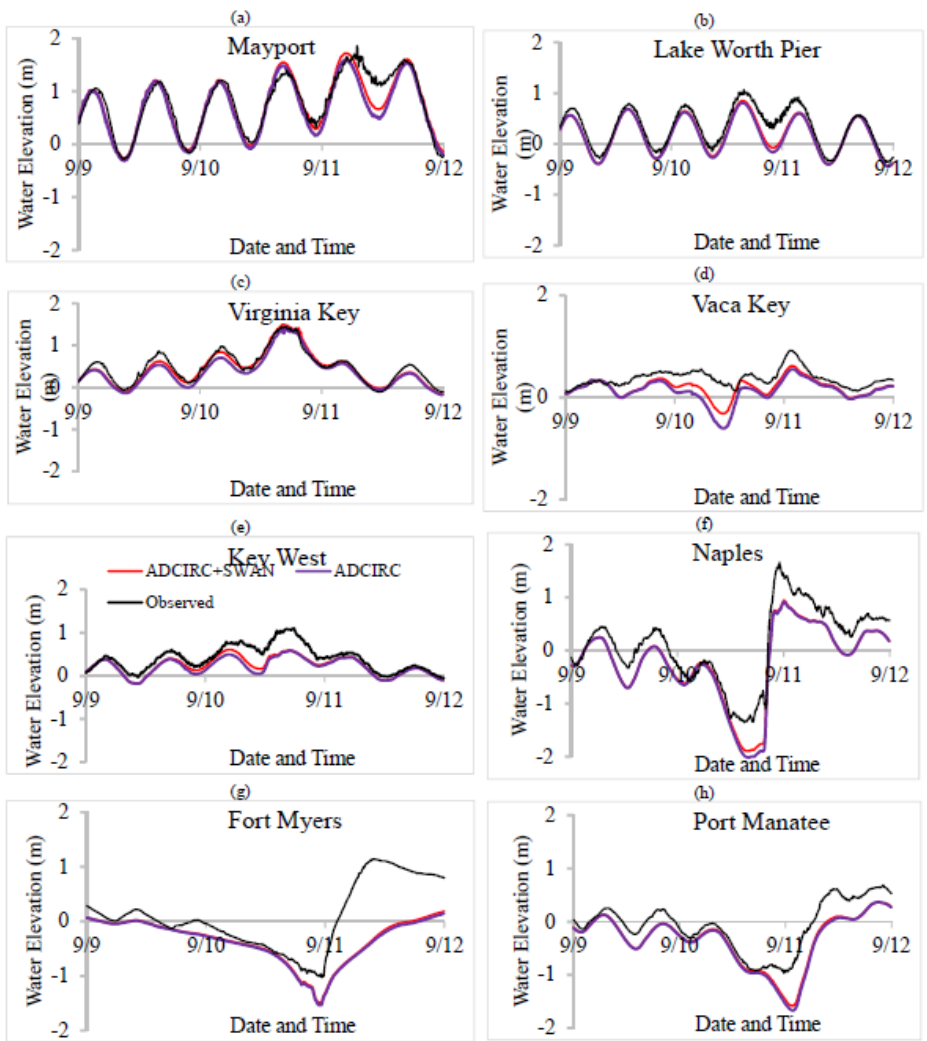
Figure 4. Observed and modeled water elevation time series (2017) for Hurricane Irma at selected stations using ACIRC and ADCIRC + SWAN: ( a ) Mayport, ( b ) Lake Worth Pier, ( c )Virginia Key, ( d ) stations using ACIRC and ADCIRC+SWAN: ( a ) Mayport, ( b ) Lake Worth Pier, ( c )Virginia Key, Key West, ( e ) Vaca Key, ( f ) Naples, ( g ) Fort Myers, and ( h ) Port Manatee. ( d ) Key West, ( e ) Vaca Key, ( f ) Naples, ( g ) Fort Myers, and ( h ) Port